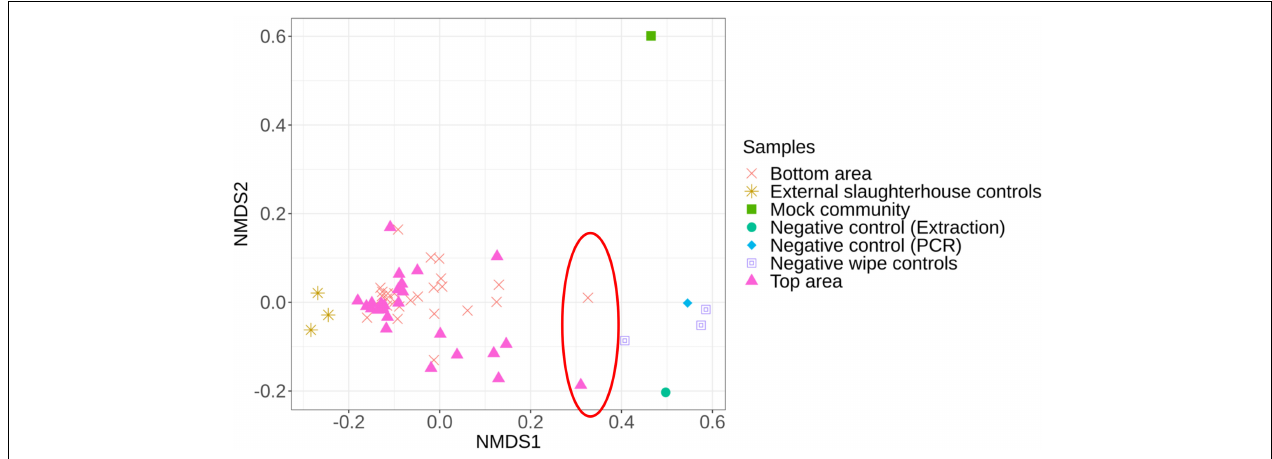
FIGURE 2 | Non-metric multidimensional scaling (NMDS) plot illustrating the microbiota structure between all samples. The red circle identifies the samples removed from the analysis due to their proximity to the negative controls.